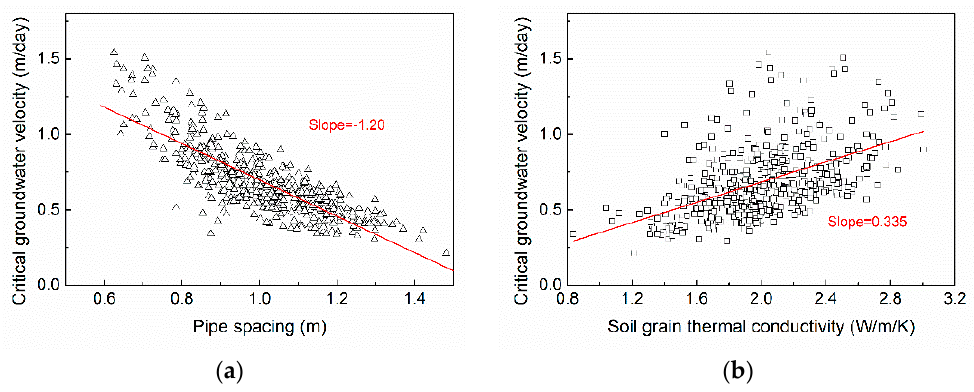
Figure 7. Scatter plot of changes in critical groundwater flow velocity with respect to ( a ) Pipe spacing; and, ( b ) Soil grain thermal conductivity based on 500 random sampling pairs. The red line represents the linear regression analysis.